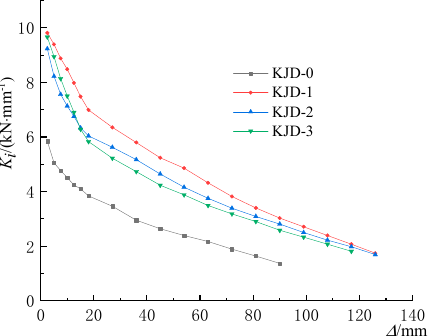
Figure 13. Stiffness degradation curves.